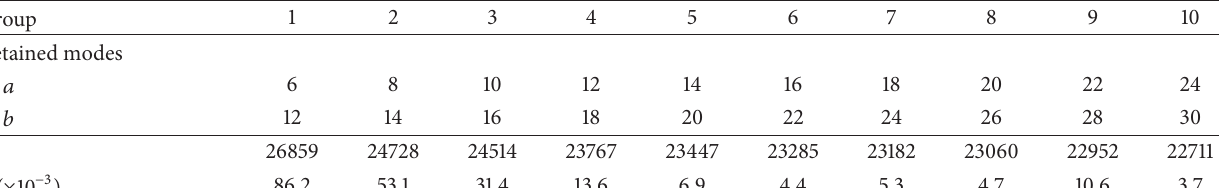
Table 1: Convergent index 𝐸 𝑖 with different retained modes.